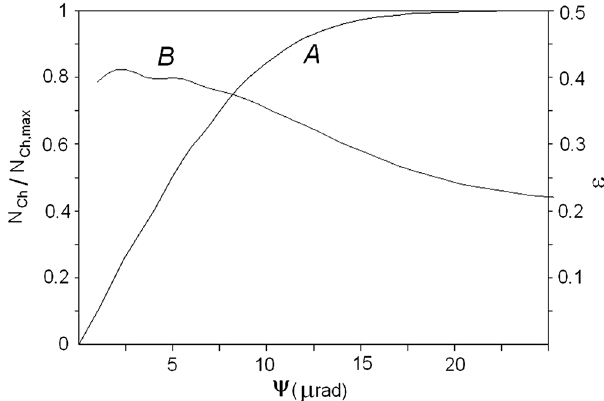
FIG. 6. The measured angular characteristics in the bending =N plane. N (curve A ) is the number of channeled Ch Ch ; max particles as a function of the maximum entrance angle ψ normalized to the total number of channeled particles N which is constant for ψ ≥ 20 μ rad. On the right ordinate axis, ε (curve B ) is the ratio of the number of channeled particles to the total number of particles within the maximum entrance